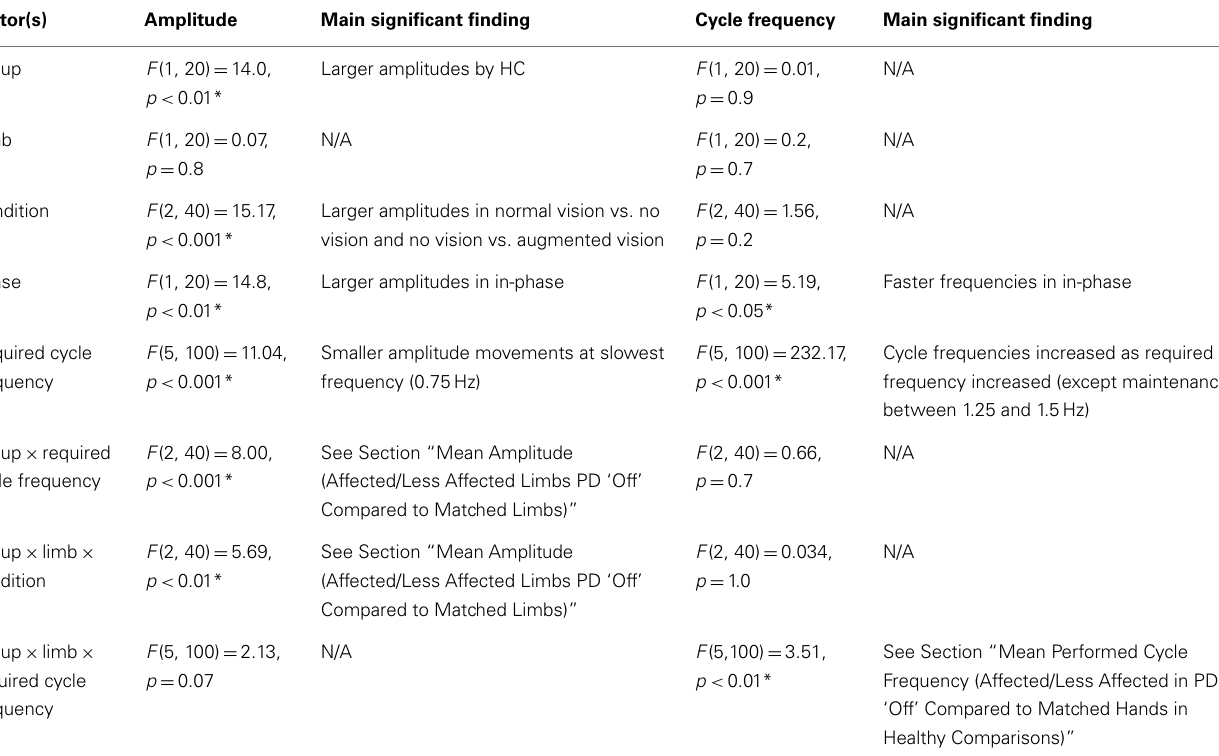
TableA3 | Statistical results fromANOVA analysis on planned comparison between PD “off” and healthy comparison (HC) participants to evaluate the effects of basal ganglia dysfunction on amplitude and frequency of movements.